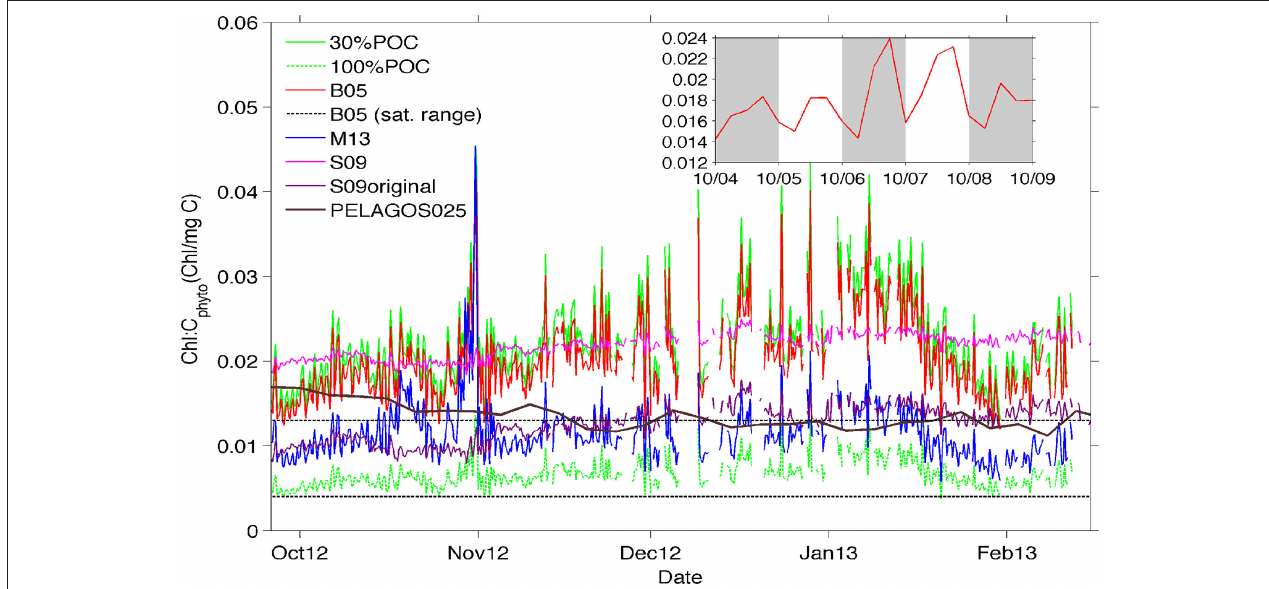
FIGURE 6 | Time-evolution of chl-a:C phyto ratios at the surface (10 m) derived from the 30%POC method (solid lighter green top line), the B05 method (red line), the M13 method (blue line), and the S09 method (pink line). In addition, Chl-a:C phyto ratios were calculated using the chl-a:POC ratio from the cruise data (which implies that all POC is phytoplankton specific) and is presented as 100%POC (darker green bottom dashed line). Included for comparision are (1) the chl-a:C phyto ratios derived from the original equation from Sathyendranath et al. (2009) presented as S09original (purple line), (2) the satellite range of ratios from Behrenfeld et al. (2005) (black dotted lines) and (3) the ratios derived from the PELAGOS025 model (McKiver et al., 2015, extracted from the model for the same geographical co-ordinates as the glider transect in time but for a year 2011 simulation, solid black line). The inset shows a detail of the daily signal for the B05